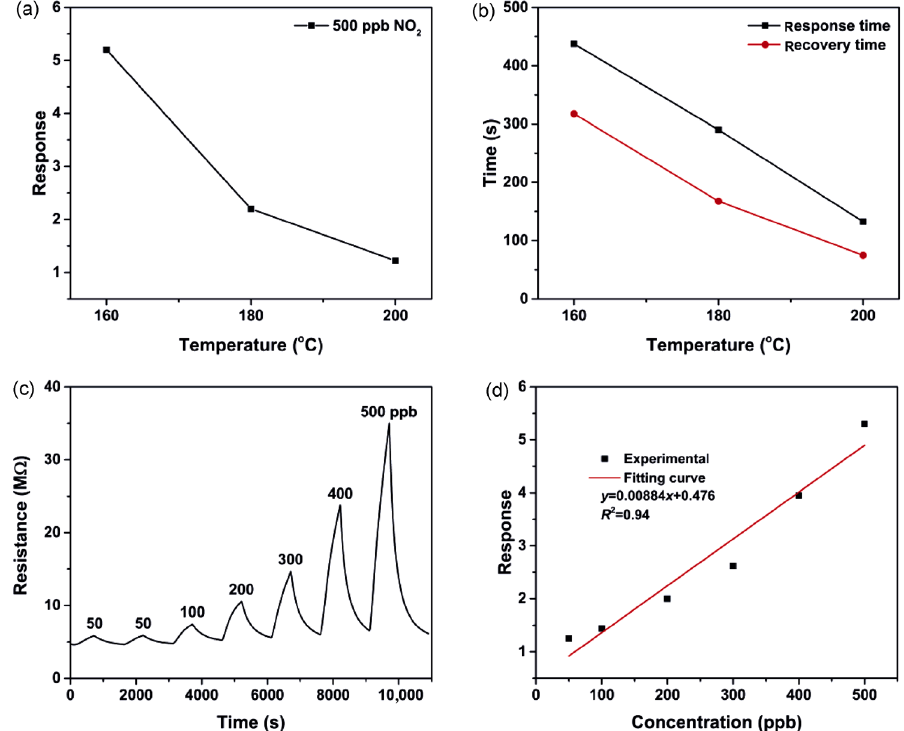
Fig. 6 (a) Response of WO 3 nanomesh to 500 ppb NO 2 as a function of operating temperature; (b) response and recovery time of WO 3 nanomesh to 500 ppb NO 2 as a function of operating temperature; (c) dynamic response of WO 3 nanomesh toward NO 2 gas at concentration ranging from 50 to 500 ppb at 160 ℃ ; (d) correlation between the sensor response and NO 2